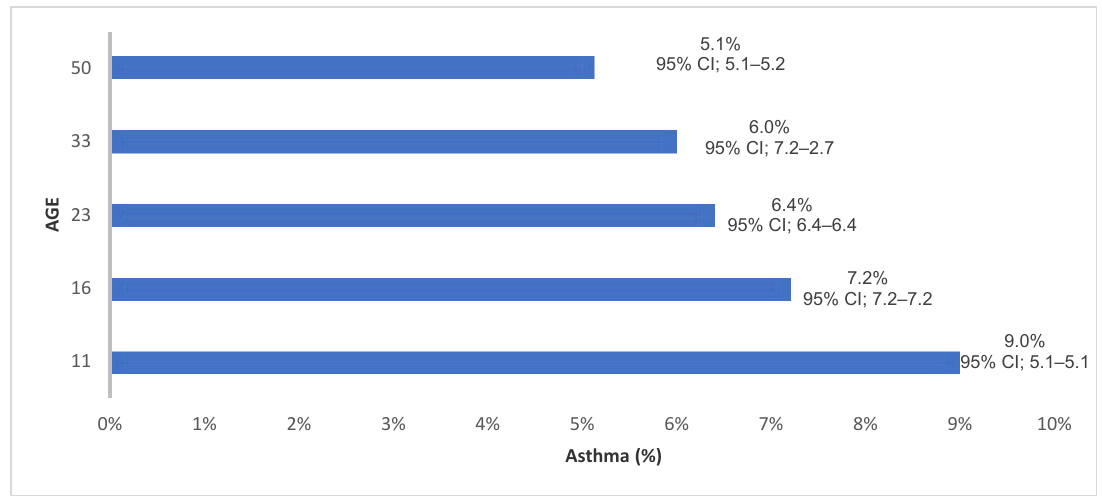
Figure 2. The prevalence of current asthma or wheezing/bronchitis in the 1958BC study from 11 to 50 years of age.